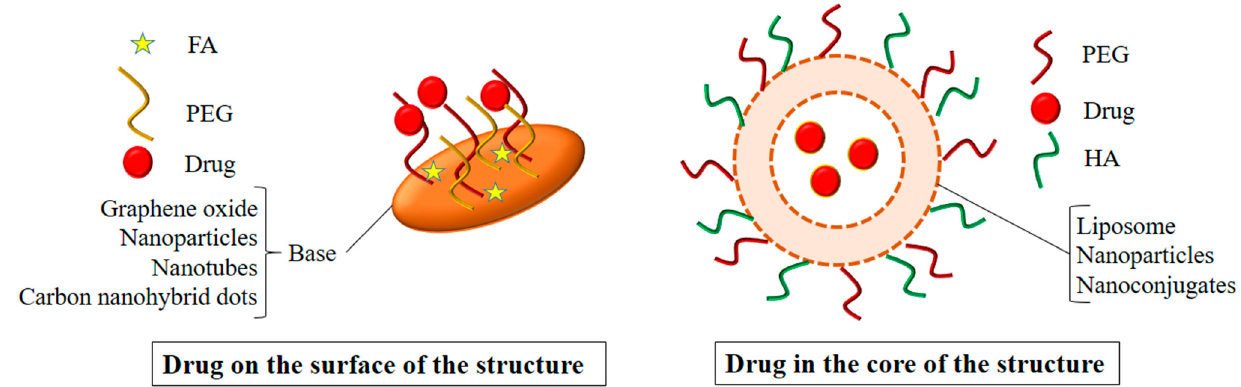
Figure 1 .A generalized structure ofPEG ‐ based nanohybrids. Figure 1. A generalized structure ofPEG-based